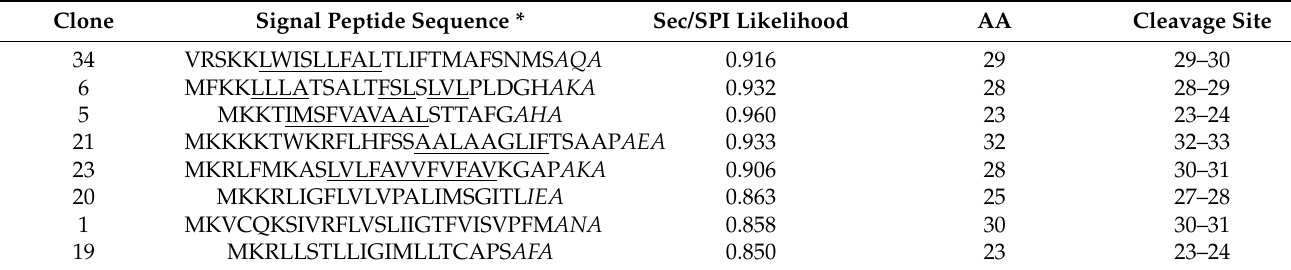
Table 1. Signal peptides sequences and their characteristics.